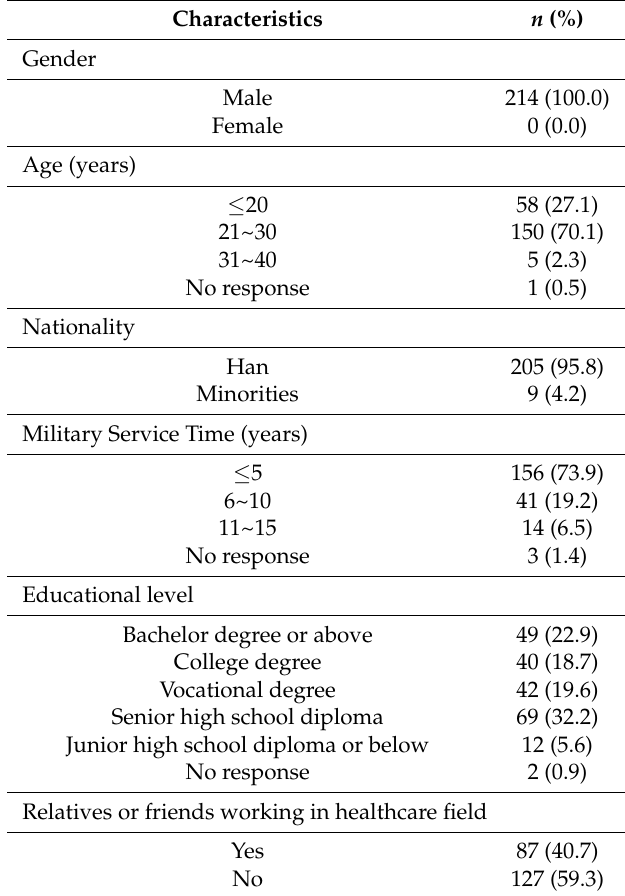
Table 1. Demographic characteristics of the respondents ( n =